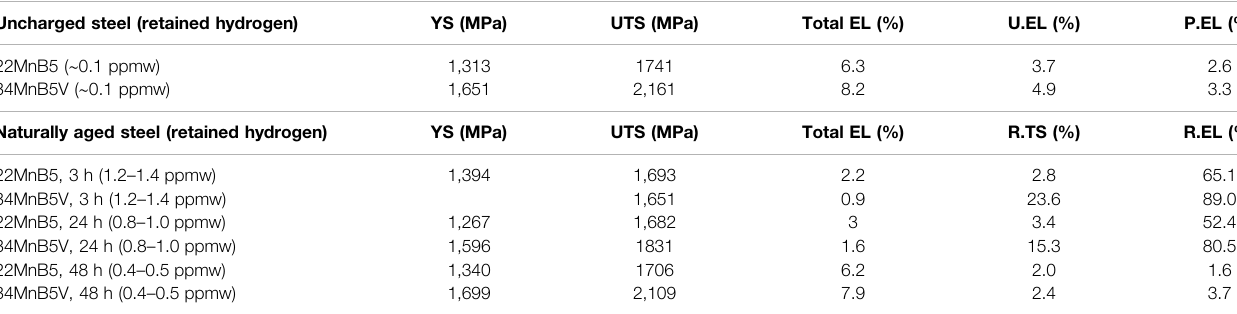
TABLE 2 | Summary of the mechanical properties of uncharged and charged-and-aged steels. Uncharged steel (retained hydrogen)